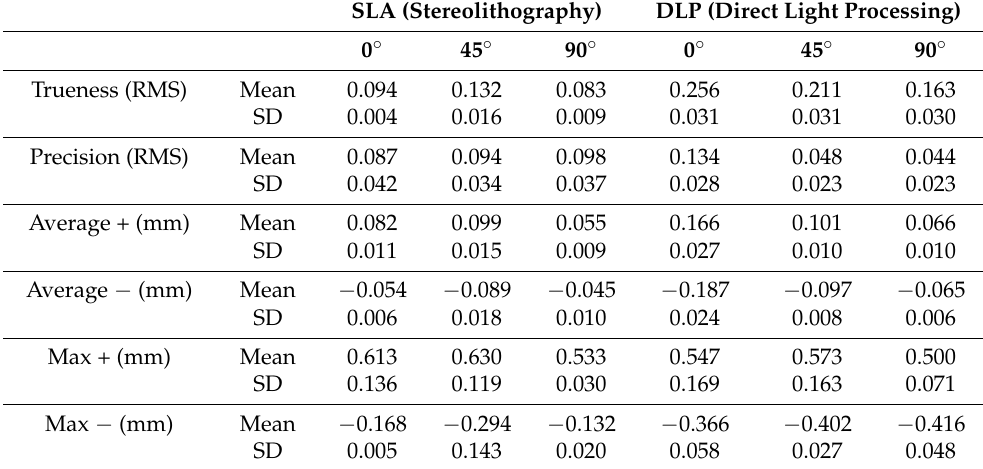
Table 1. The root mean square (RMS) values for trueness, precision and the average and maximum deviations in mm between various study